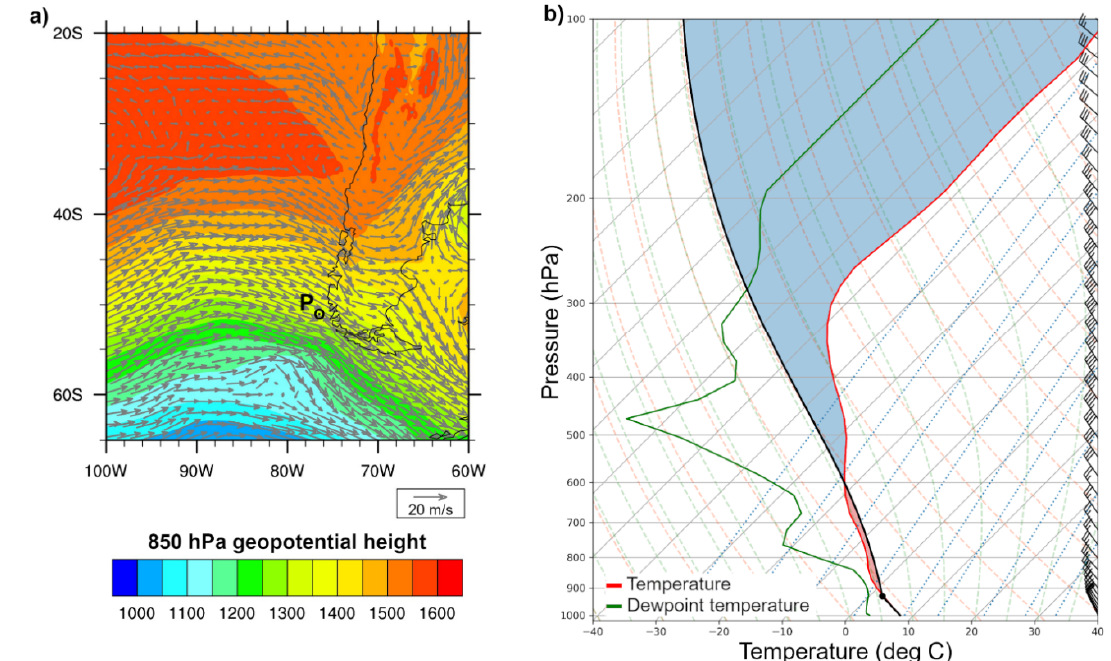
Figure 4. ( a ) Synoptic situation of 850 hPa geopotential height (color scheme) and wind vectors (arrows) derived from ERA5 and ( b ) skew-T diagram of upstream conditions, derived from WRF, at the location indicated by “P” in panel ( a ) for the supercritical case. Wind directions and speeds (one barb marks 10 m/s) are given on the right border.